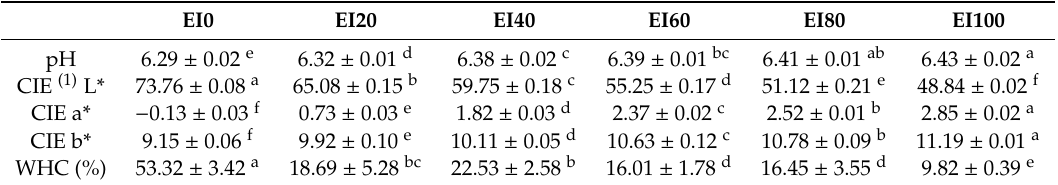
Table 1. pH, color, and water holding capacity (WHC) of the emulsion prepared with porcine myofibrillar protein and extracted edible insect protein.